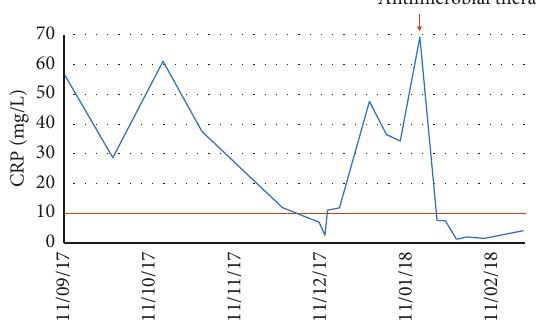
Figure 4: Course of CRP (mg/l) in case number 2.